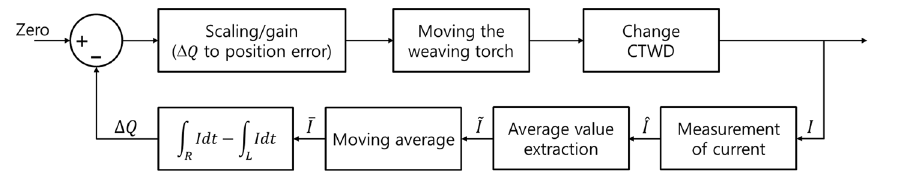
Figure 2. Data processing for seam tracking algorithm.